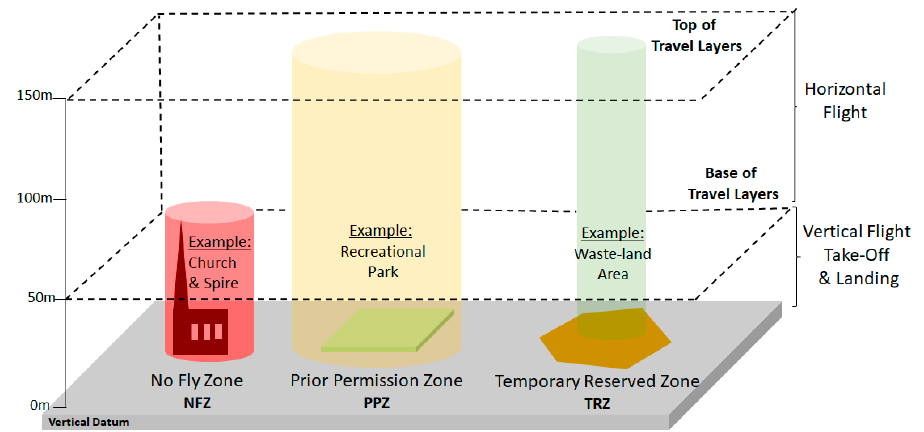
Figure 8. Schematic detailing base-layer, NFZ, PPZ and TRZ within an urban airspace environment. No Fly Zones (NFZ): In most cities few buildings reach higher than 50 m and a minimum height